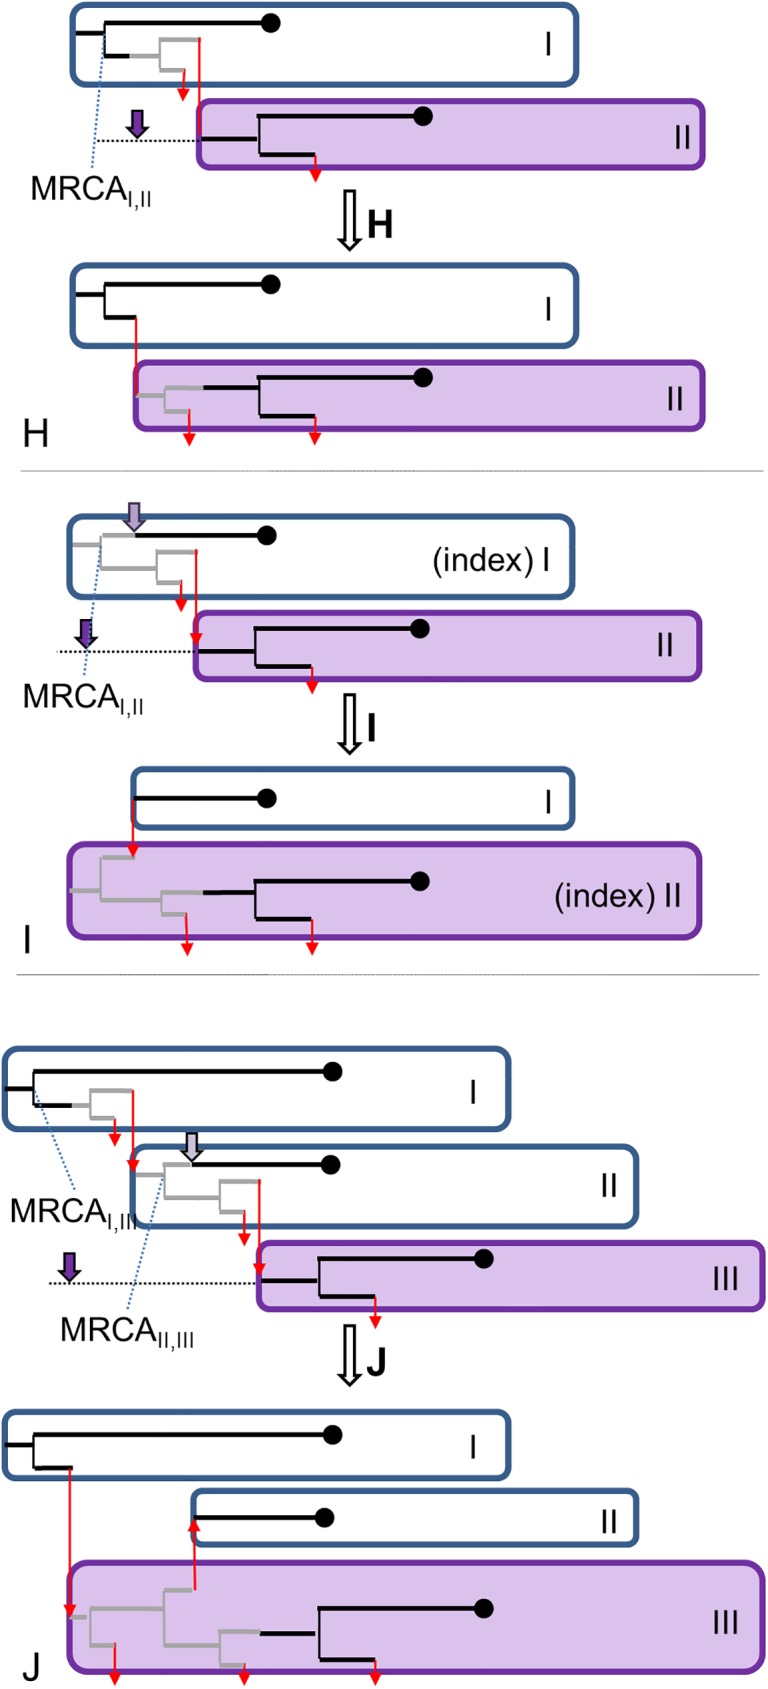
Graphics depicting proposal steps H-J for new transmission trees, keeping the phylogenetic tree unchanged. In all panels, the initial situation is at the top, and the proposal below. Every panel shows part of an outbreak, with red arrows indicating transmission to depicted or undepicted hosts. Only in panel B host I must be the index case. The purple host is the focal host, with the dark purple arrow indicating the proposal for the new infection time Ii’; the light purple arrow in panels B and C indicate the proposal for the new infection time Ij’ of the focal host’s infector. The grey parts of the phylogenetic tree are moved between the hosts. (H) the focal host is not the index case, and Ii’ is after MRCAI,II of the focal host and his infector; (I) the focal host is not the index case, and Ii’ is before MRCAI,II of the focal host and his infector (the index case), and Ij’ is after MRCAI,II; (J) the focal host is not the index case, and Ii’ is before MRCAII,III of the focal host and his infector, but after the MRCAI,III of the focal host and his infector’s infector; also, Ij’ is after MRCAII,III.